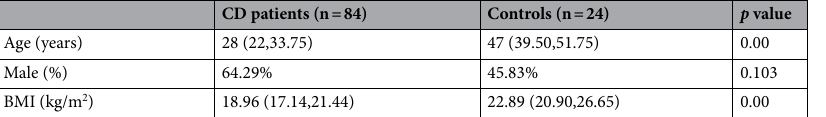
Table 1. Demographic data of the patients and controls. BMI: body mass index. For age and BMI: Wilcoxon rank-sum test. For gender distribution: Chi square test.